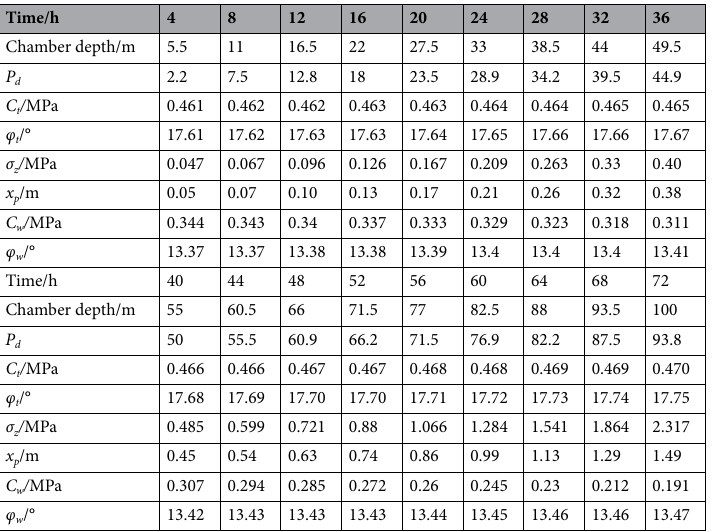
Table 7. Slice width distribution pattern and evolution weak layer parameters of a 6.4-m-wide coal pillar.